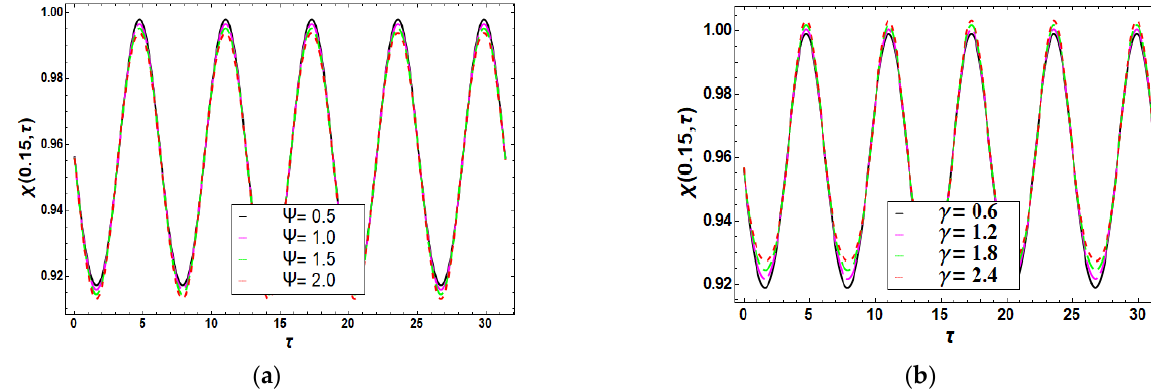
Figure 8. ( a ) Effects of ψ on χ . ( b ) Effects of γ on χ Figure 8. ( a ) E ff ects of Figure 8. ( a ) E ff ects of